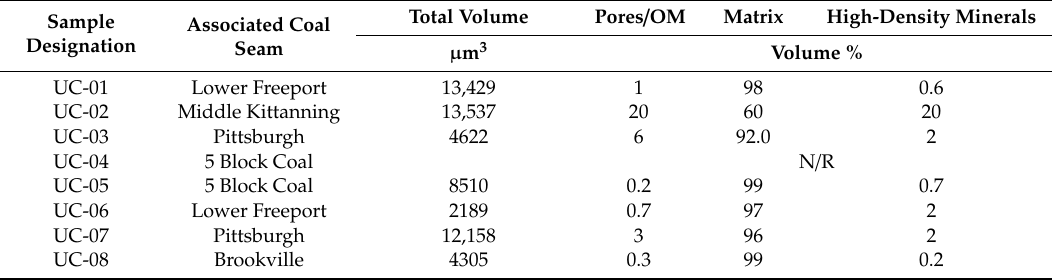
Figure 5. 2D and 3D backscattered montaged image compared to the segmented reconstruction of the Pittsburgh underclay (UC-07). Pores (light blue), matrix (dark blue), and high density and REE- bearing phases (red).